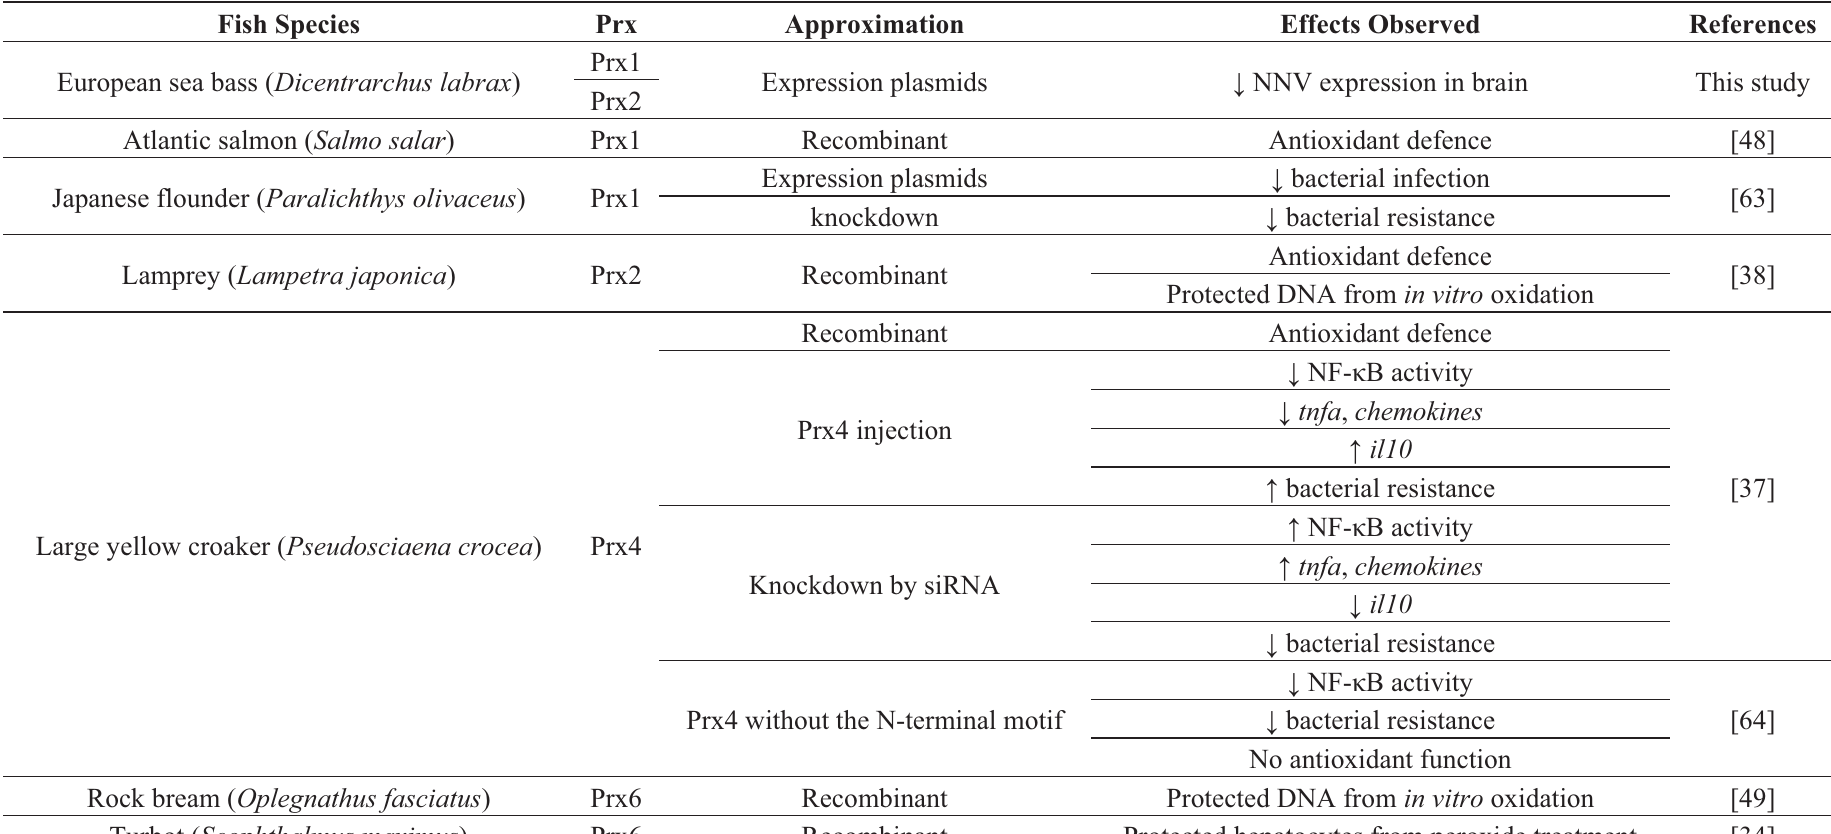
Table 2. Summary of the functional studies evaluating the role of fish